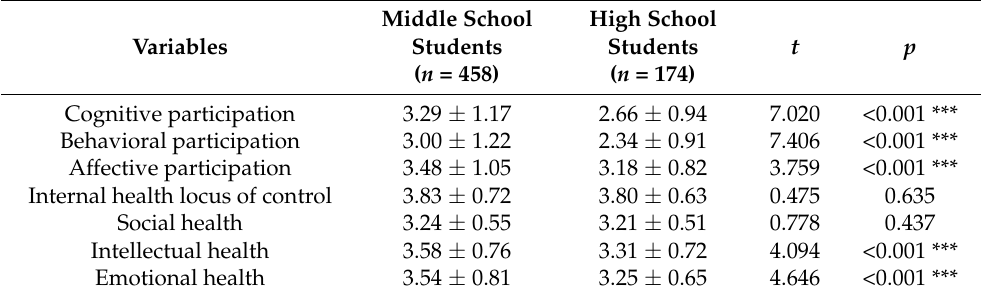
Table 6. School-level differences in all variables.